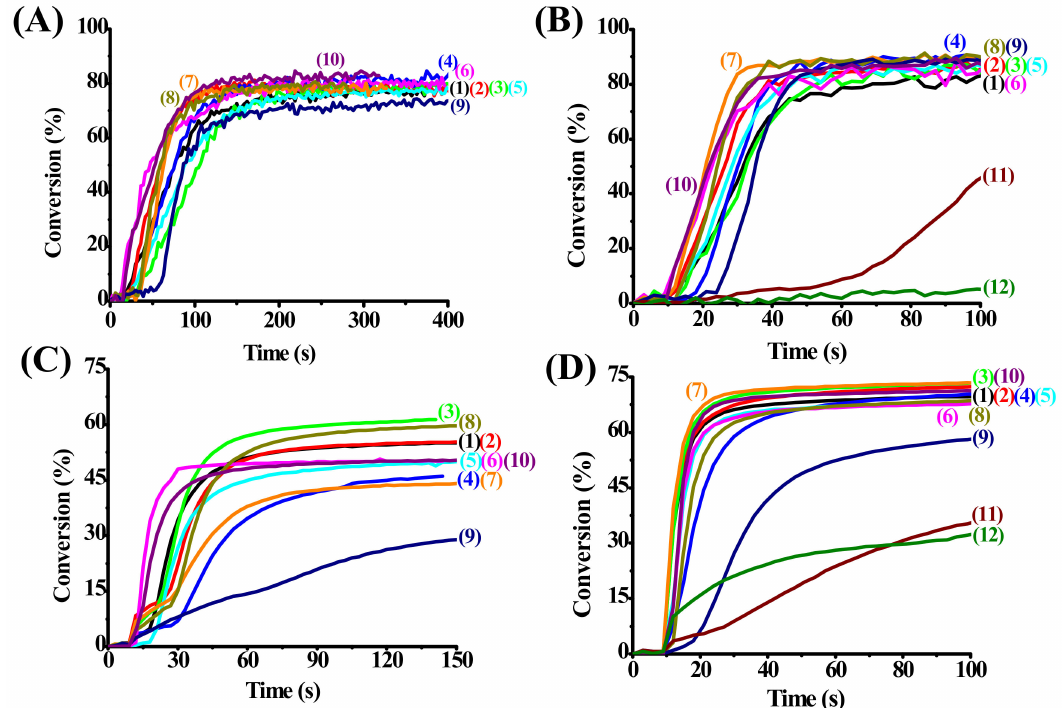
Figure 2. Polymerization profiles of TA (acrylate function conversion vs. irradiation time) in thick samples: ( A ) using two-component PISs Napht/Iod (0.05%/1% w/w ); ( B ) using three-component PISs Napht/Iod/NPG (0.05%/1%/1% w/w/w ). In thin samples: ( C ) two-component PISs Napht/Iod (0.05%/1% w/w ); ( D ) using three-component PISs Napht/Iod/NPG (0.05%/1%/1% w/w/w ). Illumination with LED @405 nm: (1) Napht-1, (2) Napht-2, (3) Napht-3, (4) Napht-4, (5) Napht-5, (11) Iod/NPG, Illumination with LED @455 nm: (6) Napht-1, (7) Napht-2, (8) Napht-3, (9) Napht-4, (10) Napht-5, and (12) Iod/NPG (1%/1% w/w ). Irradiation starts at t = 10 s. Table 2. Final reactive function conversions (FC%) for TA using two-component PISs upon visible light irradiation using the LEDs @405 nm and 455 nm.